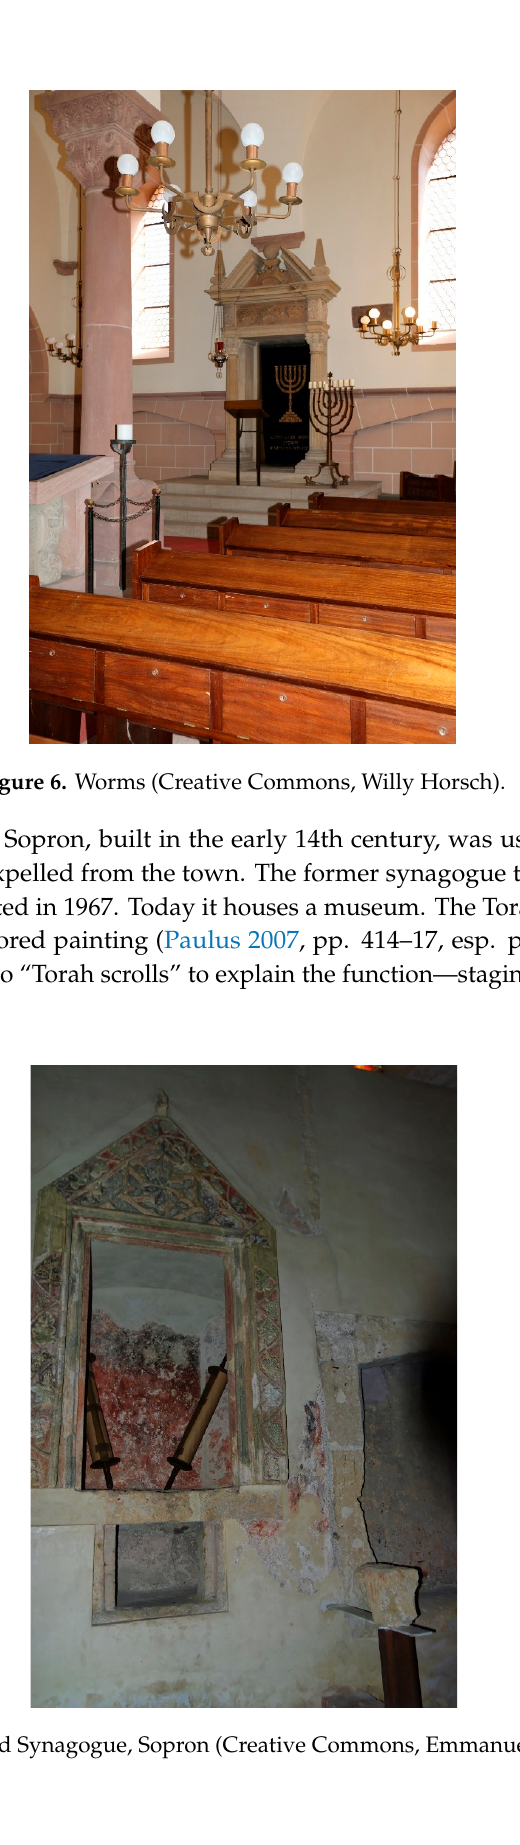
Figure 8. Private Synagogue, Sopron (Simon Paulus, ca. 1970, used with permission). We can see the opposite approach in Maribor (Paulus 2007, pp. 401–4). Here, the Torah Ark was renovated too—but by aligning the surface and creating a regular form. Today, the former Torah Ark is just a white, clean niche in the eastern wall of the former synagogue (Figure 10). The building today functions as a place for concerts, lectures and exhibitions—and the Torah Ark disappeared almost completely and has no function at all. The Maribor synagogue is an example, using synagogues as meeting places or function rooms—this is quite rare in medieval synagogues; later synagogues often are used like that.